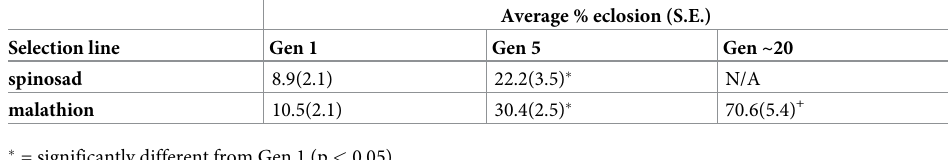
Table 2. Eclosion success following exposure to discriminating dose before and after